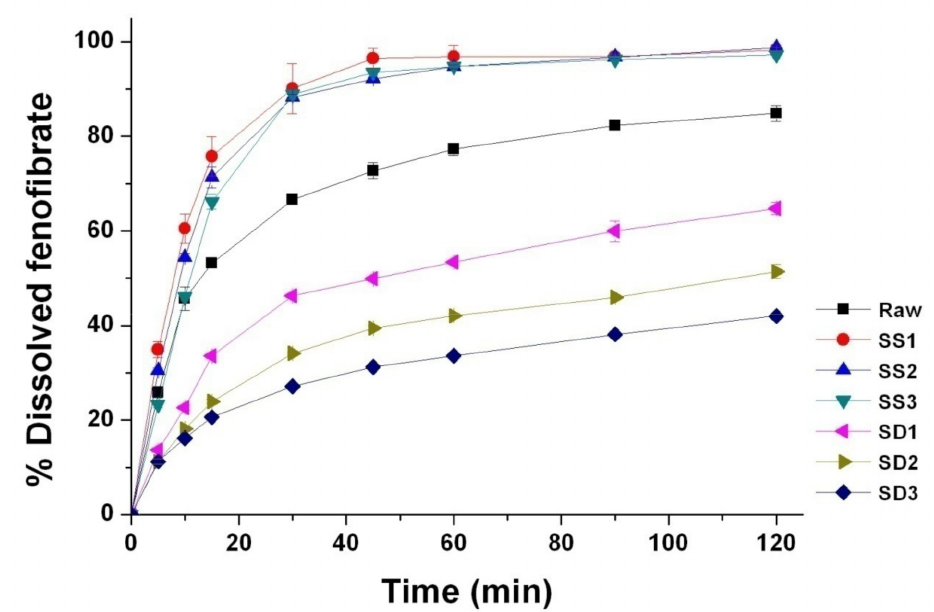
Figure 6. Dissolution profiles of the fenofibrate microcomposite particles with surface-active additives prepared using the SA-SD process and the SD